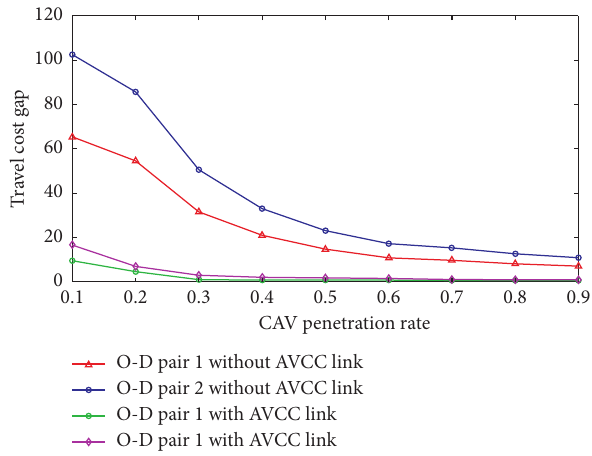
Figure 4: Travel cost gap for HDV users on each O-D